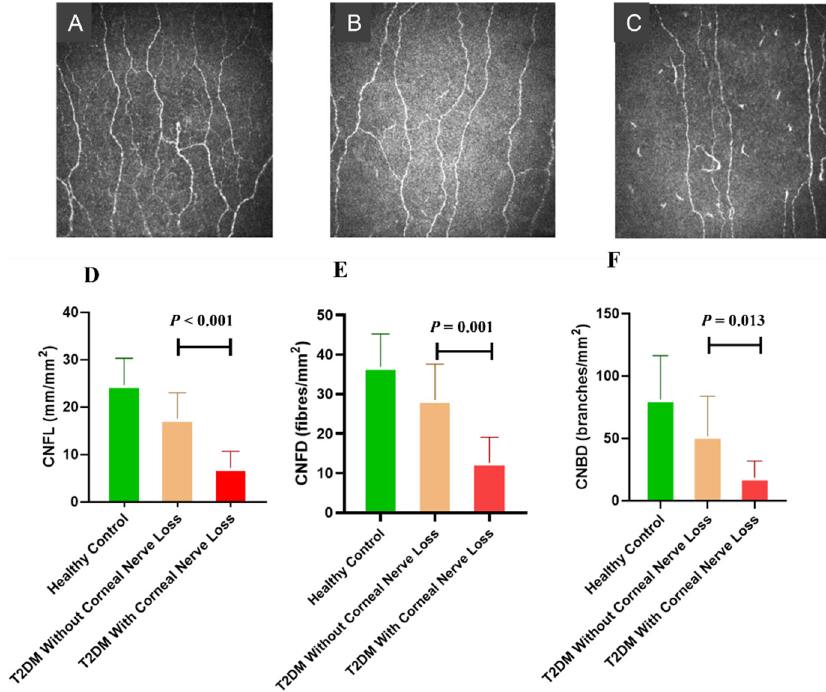
Figure 1. CCM image from a healthy control ( A ), a participant with type 2 diabetes mellitus (T2DM) without corneal nerve loss ( B ), and a participant with T2DM with corneal nerve loss ( C ). There was a significant reduction in CNFL ( D ), CNFD ( E ), and CNBD ( F ) compared to healthy controls (graph represents mean ± SD).